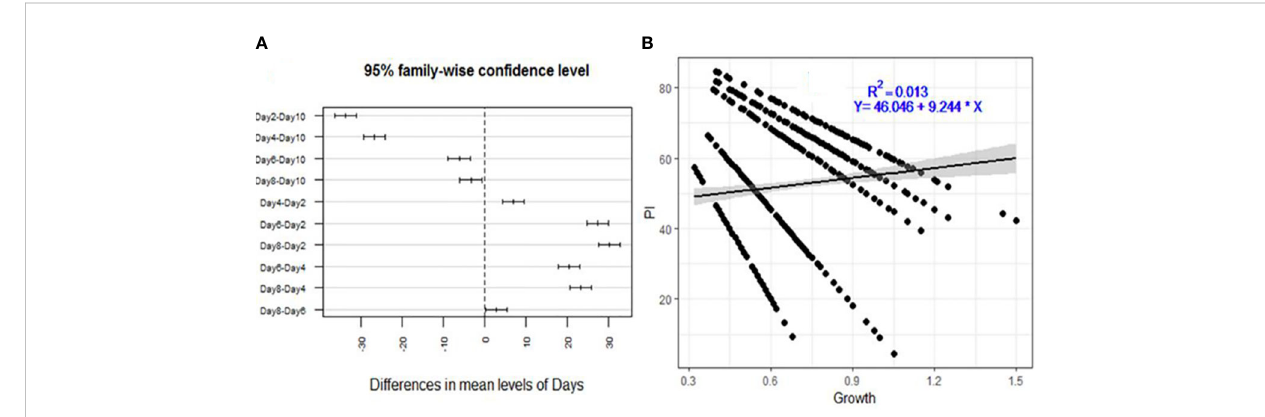
FIGURE 2 Descriptive analysis of percentage inhibition (PI) for the 175 Trichoderma isolates tested against F . xylarioides . (A) A pair-wise comparison of incubation period (days) and (B) Regression analysis between mycelial growth. PI, Percentage of Inhibition.